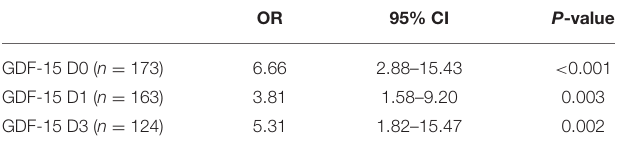
TABLE 2 | Association between 3-month mortality and GDF-15 levels in the third tertile at D0 (GDF > 2,088 pg/mL), D1 (GDF > 1,784 pg/mL), and D3 (GDF > 1,575 pg/mL) in univariate logistic regression analysis.